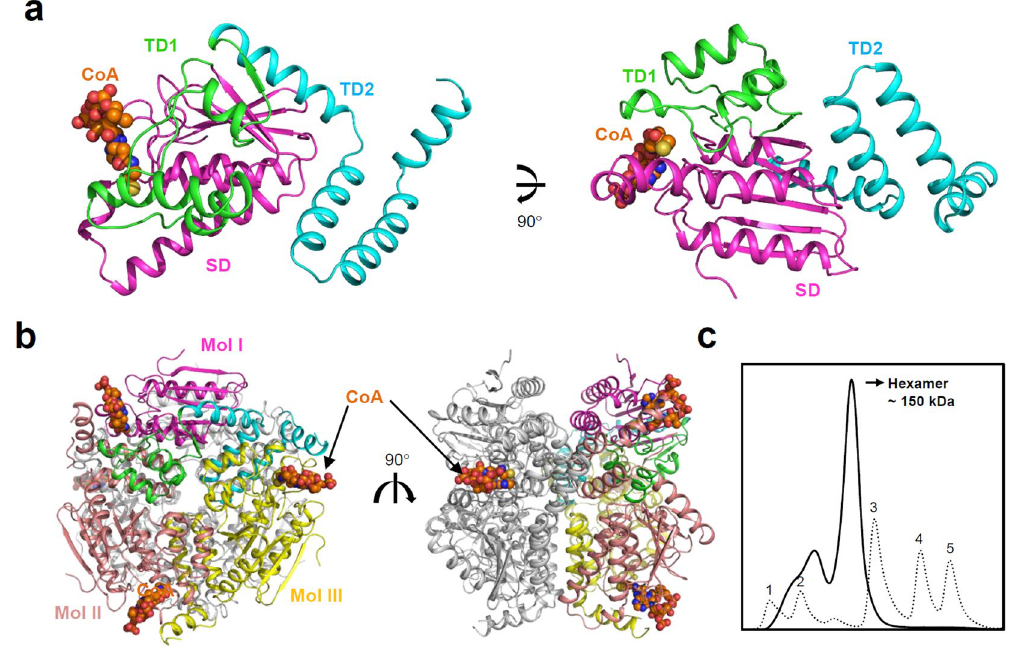
Figure 2. Overall structure of Ms 3HPCD. ( a ) The monomeric structure of Ms 3HPCD. The Ms 3HPCD structure is shown as a cartoon diagram. SD, TD1, and TD2 are distinguished by different colors of magenta, green, and cyan, respectively, and labeled appropriately. The bound CoA molecule is shown as an orange colored sphere. The right figure is the left figure rotated horizontally by 90°. ( b ) Hexameric structure of Ms 3HPCD. The hexameric structure of Ms 3HPCD is presented as a cartoon diagram. Mol I is presented with a color scheme same as ( a ). Mol II and III are presented with colors of salmon and yellow, respectively. The other trimer is shown with a grey color. The bound CoA molecule is shown as sphere models with an orange color. The right figure is rotated by 90° vertically from the left figure. ( c ) Size-exclusion chromatography of Ms 3HPCD. The Ms 3HPCD and standard samples are distinguished with solid and dotted lines, respectively. 1, 2, 3, 4, and 5 indicate void and standard samples of Ferritin (440 kDa), Conalbumin (75 kDa), Carbonic anhydrase (29 kDa), Ribonuclease A (13.7 kDa),